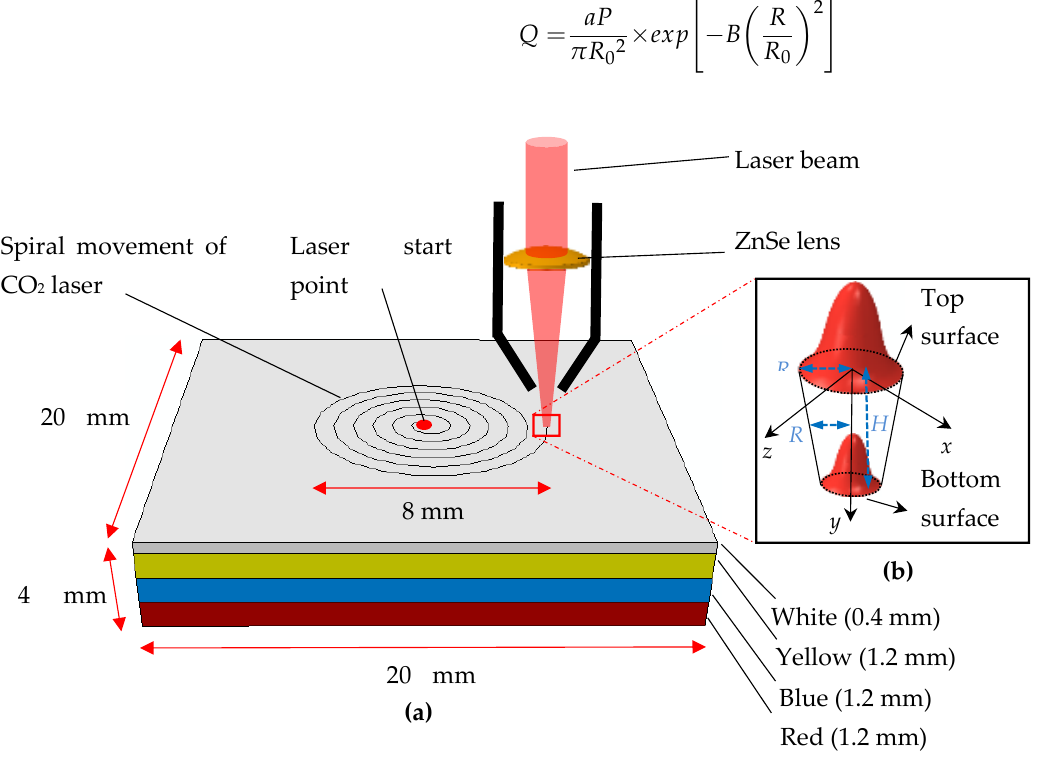
Table 5. Thermal properties of paints [20].